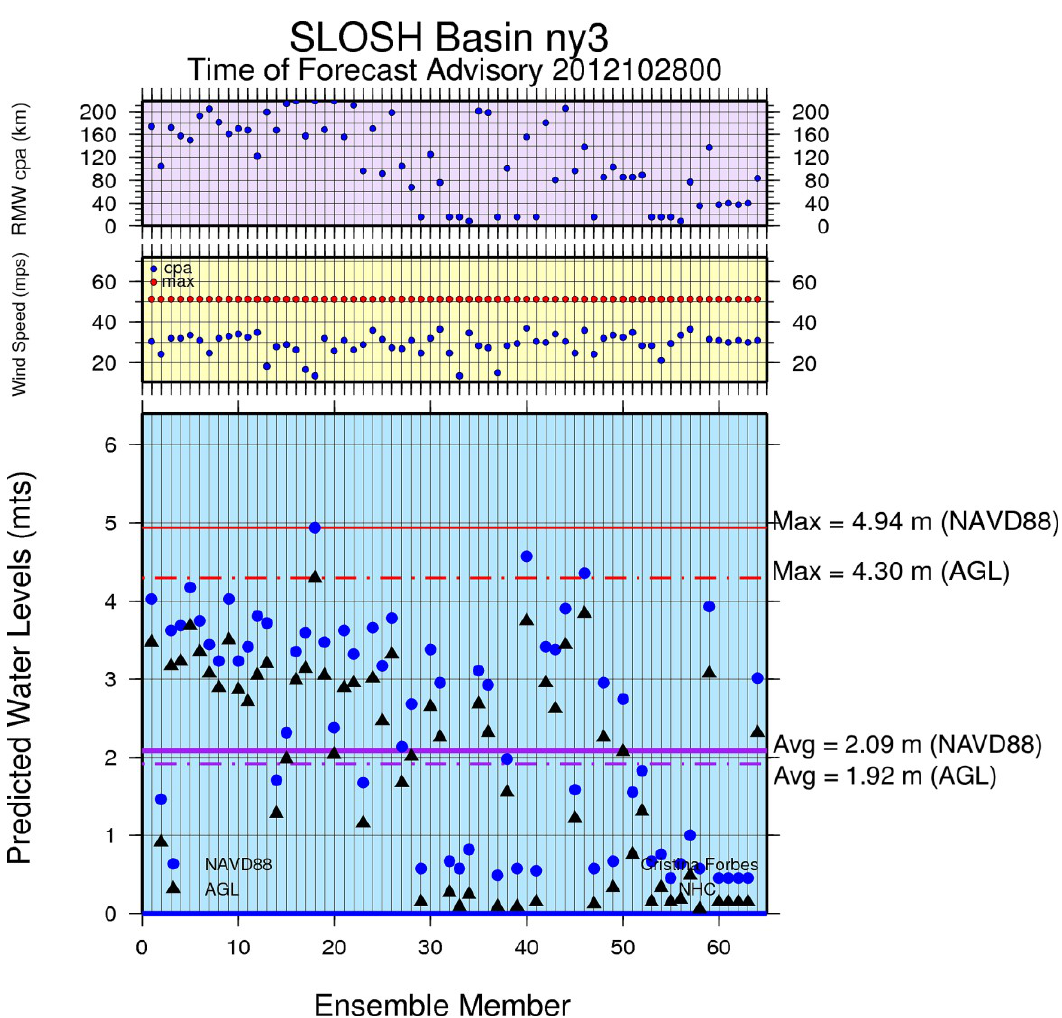
Figure 7. Summary plot of the ensemble results for the simulations of Hurricane Sandy (2012) valid 48 h prior to landfall. The bottom ( blue ) panel shows the maximum water levels relative to both the NAVD88 vertical datum ( dark blue dots ) and AGL (black triangles) for each ensemble member. The solid ( dashed ) red lines show the maximum water levels in NAVD88 (AGL) and the solid (dashed) purple lines show the average water levels in NAVD88 (AGL) for each ensemble member. The middle ( yellow ) panel shows the maximum wind speed ( red dots ) and wind speed at the closest point of approach (CPA) ( blue dots ) of each model guidance ensemble member. The top ( purple ) panel indicates the radius of maximum winds at CPA for each model/aid ensemble